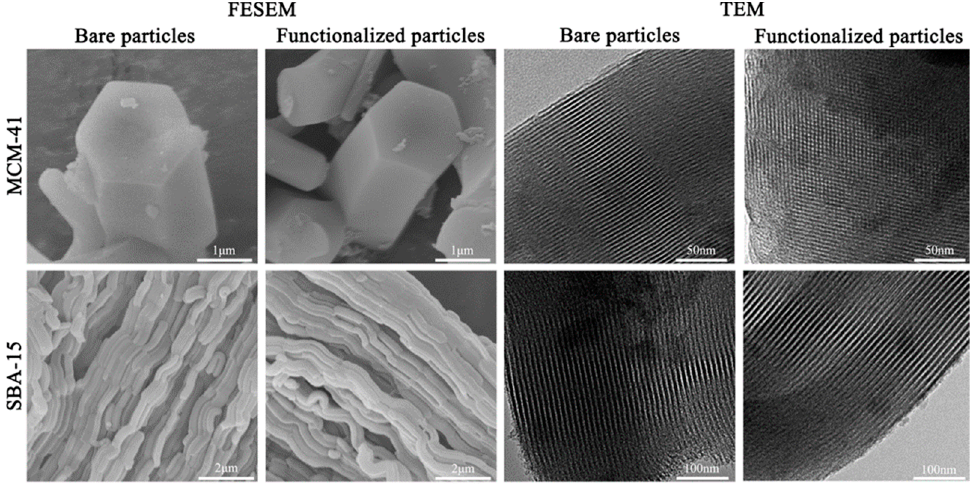
Figure 2. FESEM and TEM images of MCM-41, SBA-15, Thy-MCM-41, and Thy-SBA-15.